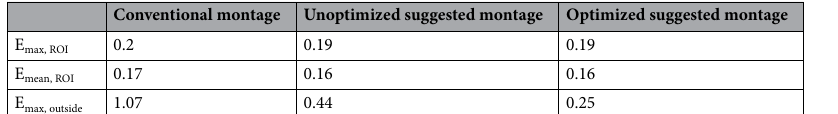
Conventional montage Unoptimized suggested montage Optimized suggested